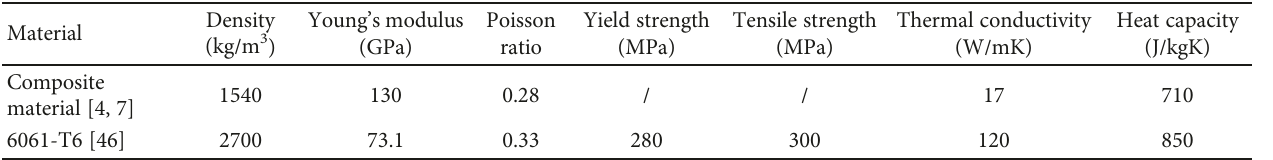
Figure 4: The honeycomb aluminum plate: (a) the size of hexagon honeycomb aluminum and (b) the size of the honeycomb aluminum plate. Table 3: Material properties.